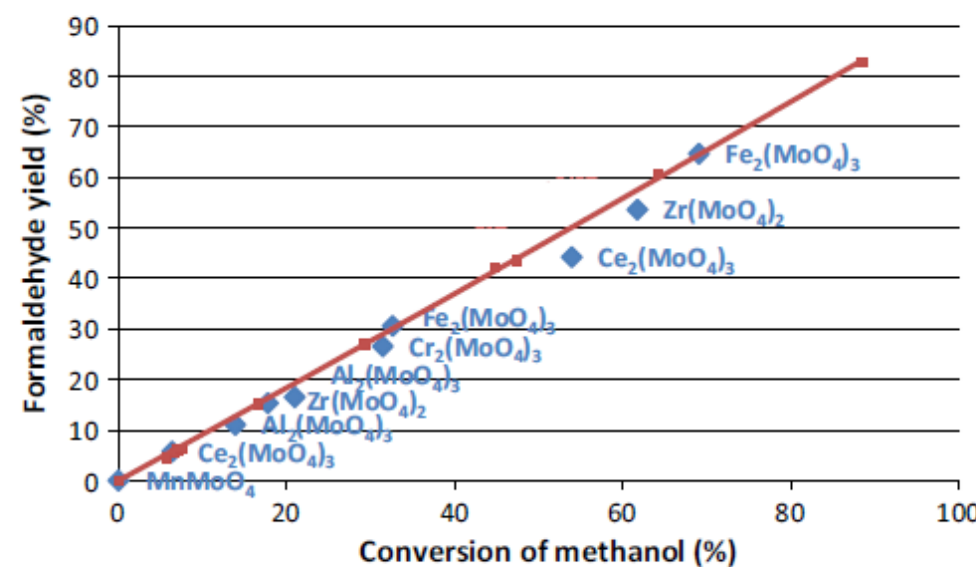
Figure 2. Comparisons of the yield and conversion of formaldehyde over the various molybdates in the Formox process. Reprints from [99]. Copyright (2021), with permission from Springer Nature. Table 3. Represents the development of the Formox process over the iron molybdate catalyst from the year 1959 [99,100]. Years Process Development Results Dried granules of catalyst were used, and the feed consisted of 6.5 1959 vol% methanol in the air.